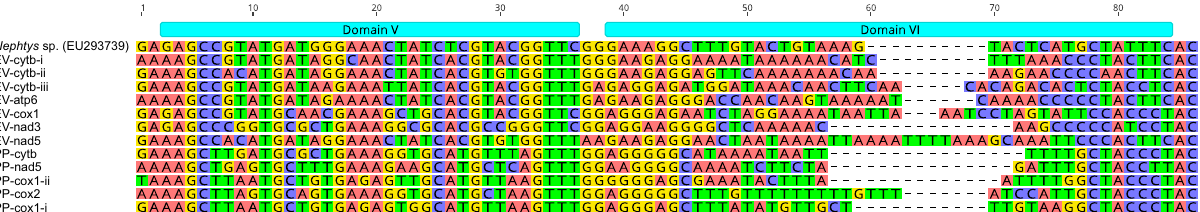
Figure 3. Group II ORF-less ribozyme domains V and VI alignments of Exechonella vieirai and Parantropora penelope with reference sequence Nephtys sp. (domain annotation from Fig. 1 in 30